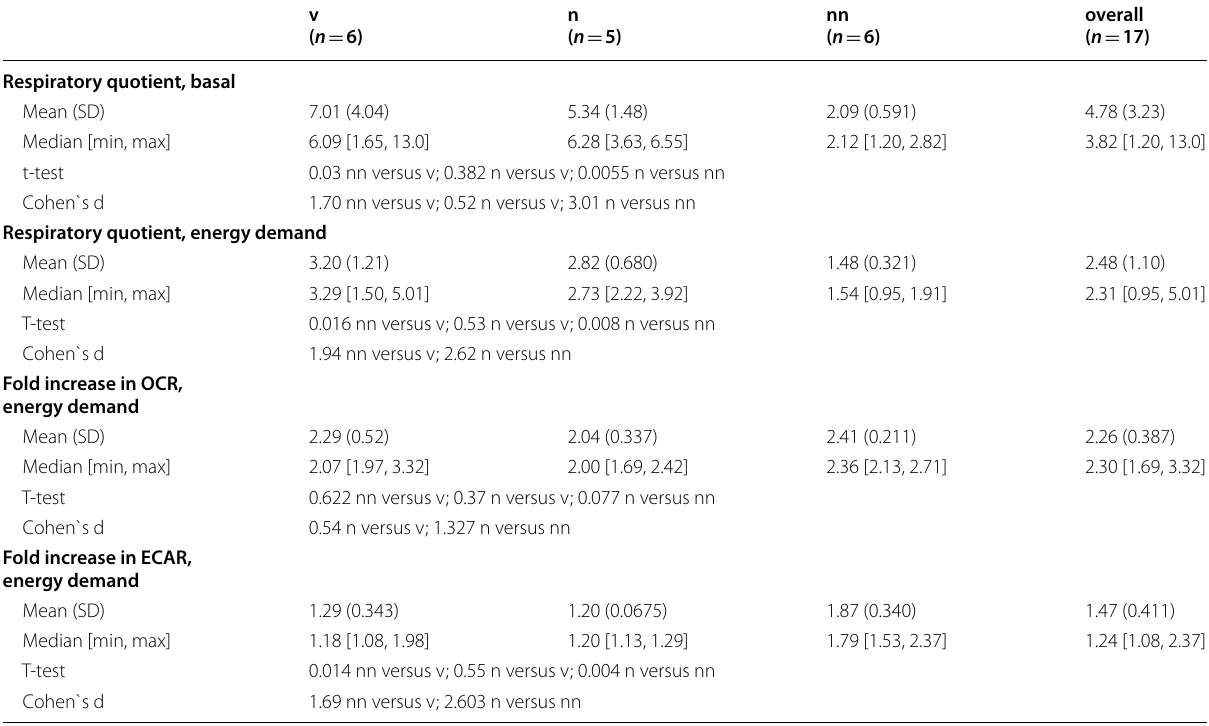
Table 3 Energy phenotype. The distinct parameter were taken before (v), after the first 10-pass OHT (n) and after the second 10-pass OHT one week later (nn). The data represent cumulative data from the respective subjects and are expressed as means median. The statistics include the t-test and the Cohen`t d test. OCR: oxygen comsumption rate in pmolO2/min; ECAR: